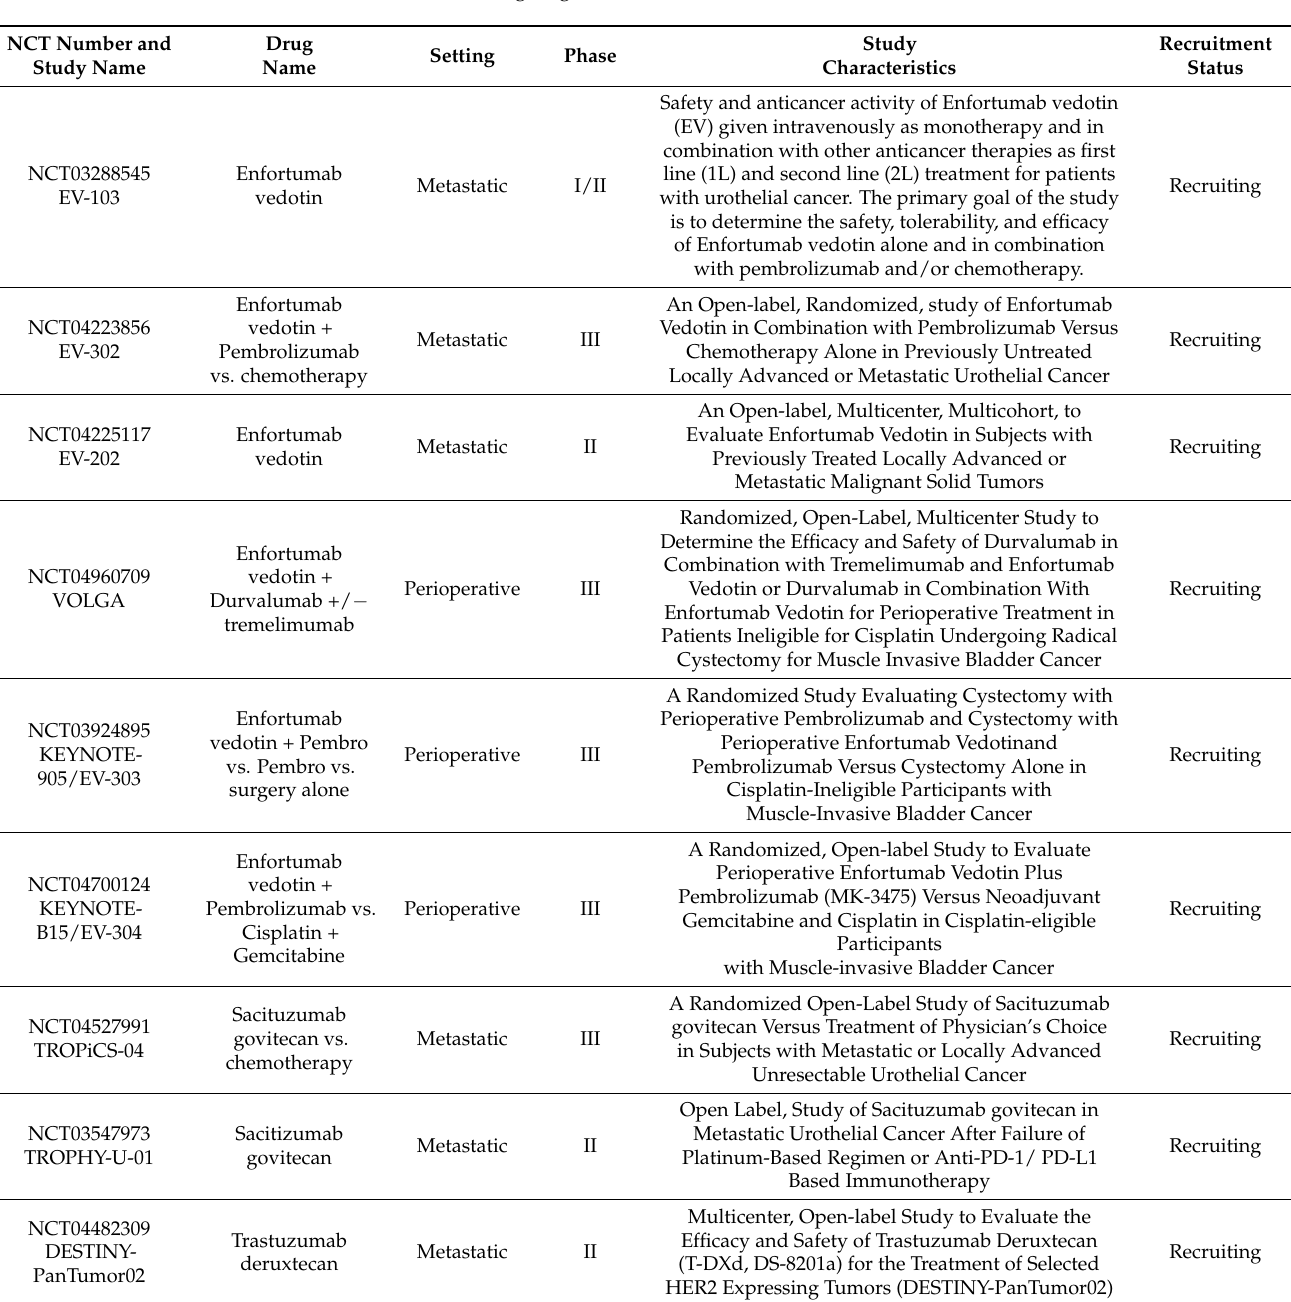
Table 2. Current Ongoing Trials for ADCs in Urothelial